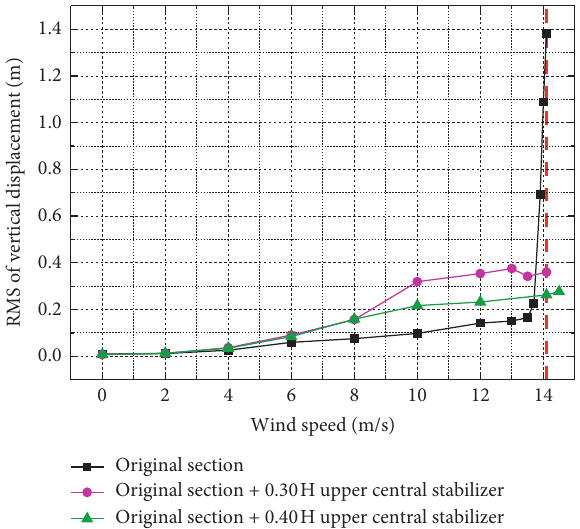
Figure 9: Mean wind pressure coefficients of upper surfaces.